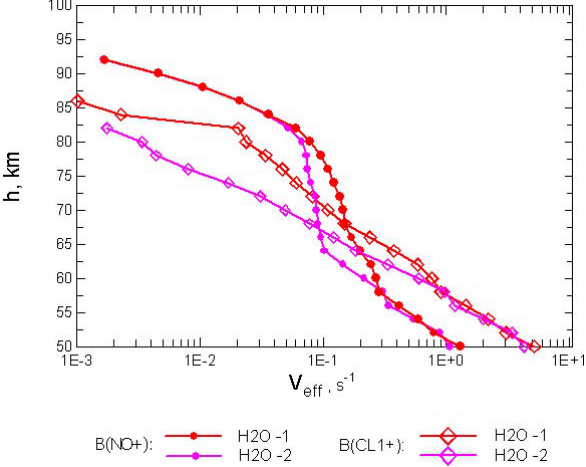
) efficiencies calculated for winter and Fig. 3b. B (NO + ) and B (Cl + 1 summer based on the H 2 O-1 and H 2 O-2